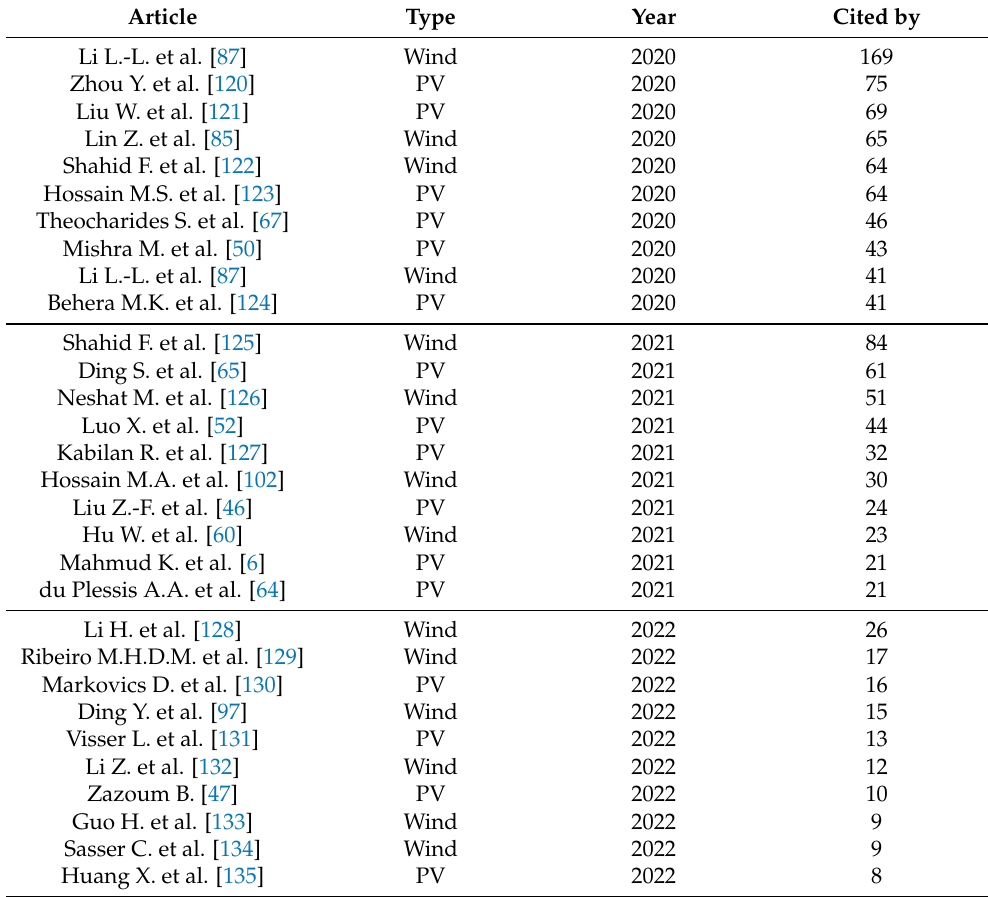
Table 3. Top cited